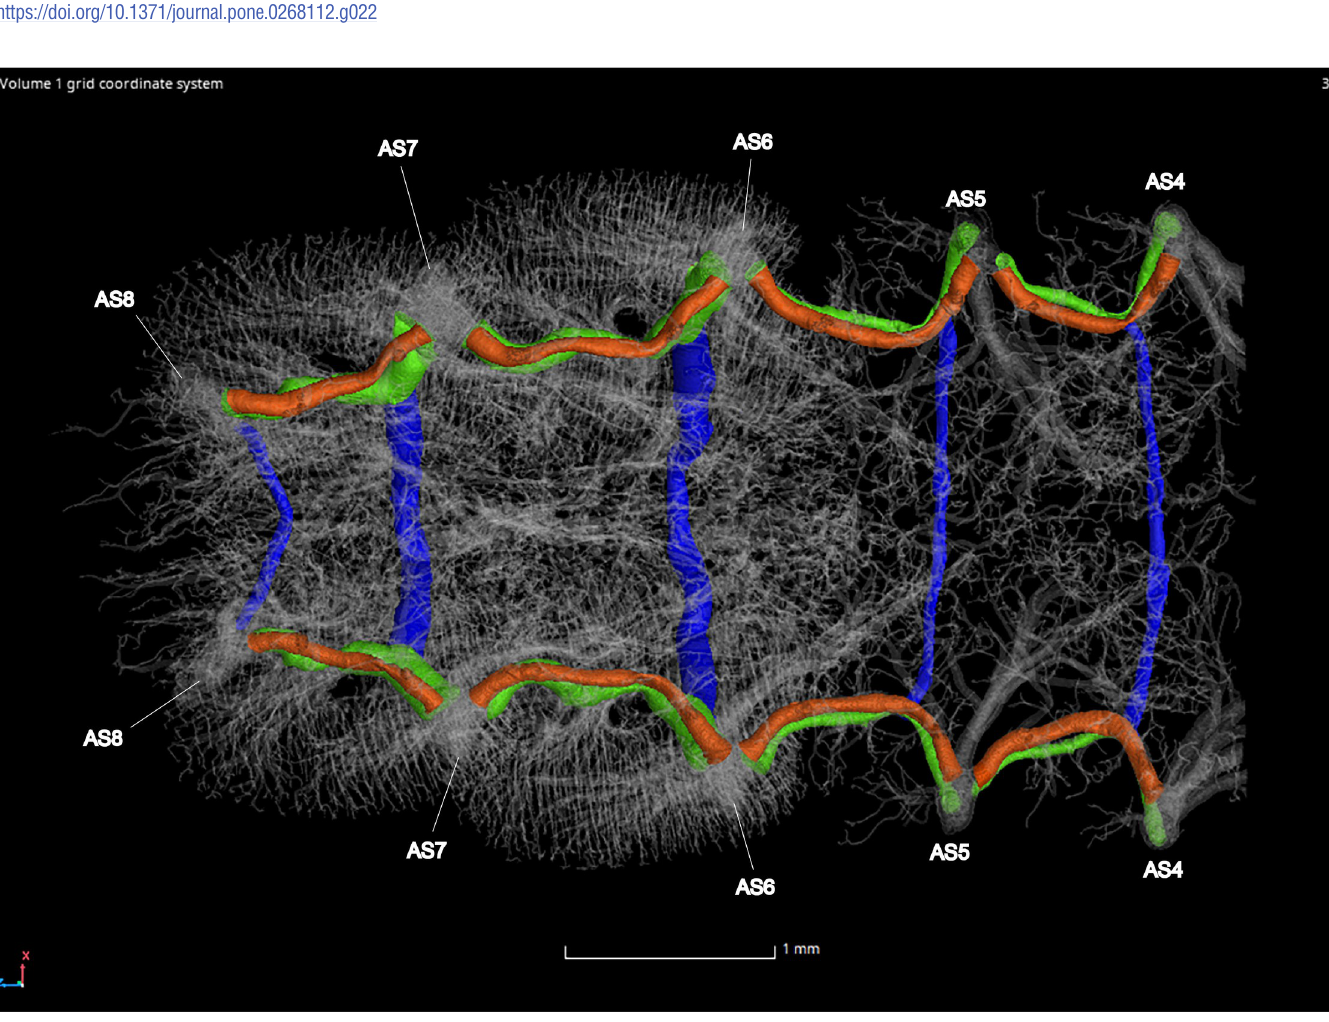
Fig 23. Dorsal view of the adult male Photinus pyralis tracheal system. Ventral commissures (VC; blue), dorsal longitudinal trunks (DLT; orange), and ventral longitudinal trunks (VLT; green) highlighted for volumetric analysis.